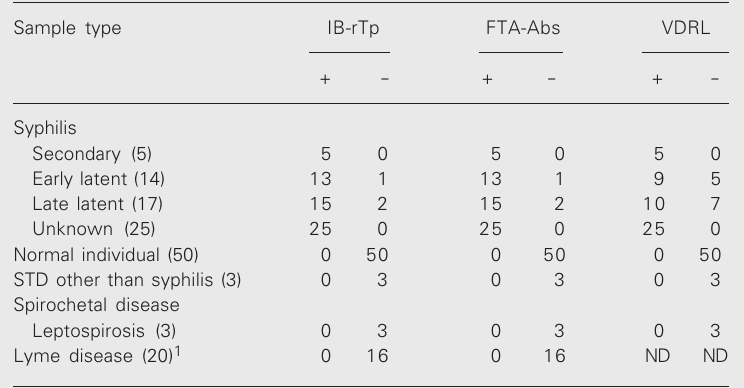
Table 1. Results of IB-rTp and other serological tests for syphilis (FTA-Abs and VDRL) for different clinical serum samples